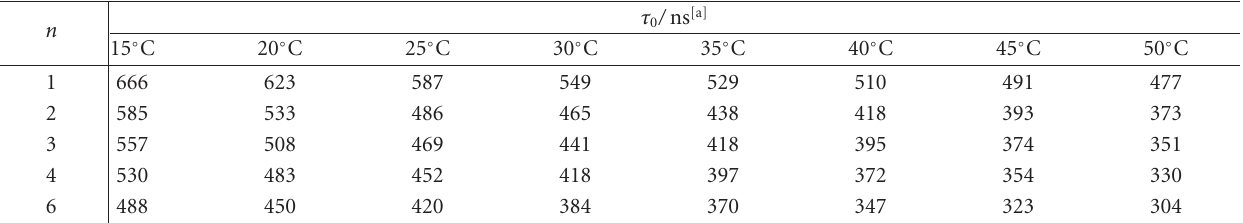
Table 2: Dependence of the fluorescence lifetime on the length of (Gly-Ser) n -Dbo-NH 2 probe-only-labeled peptides in D 2 O at di ff erent temperatures.